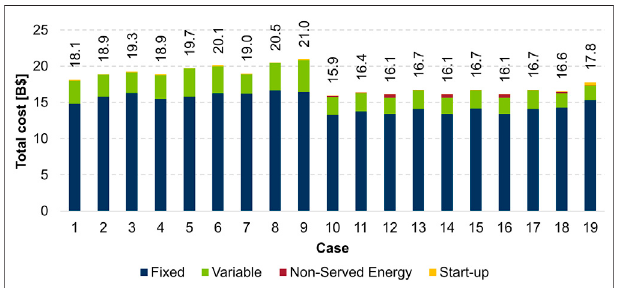
FIGURE 10 | Normalized total cost for the different cases in billion dollars.